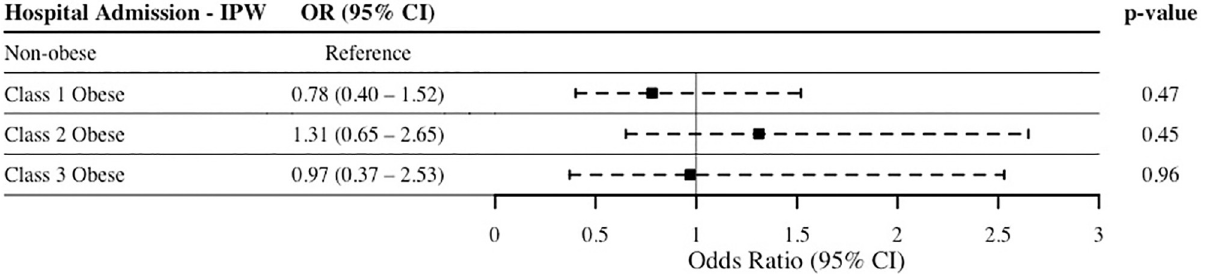
Fig 2. IPW-adjusted logistic regression of all-cause hospital admission. Outcome regressed on obesity categories, with non-obese (BMI < 30 kg/m 2 ) patients used as the reference group. Abbreviations: Abbreviations: IPW, inverse probability-weighing; OR, odds ratio; CI, confidence interval.